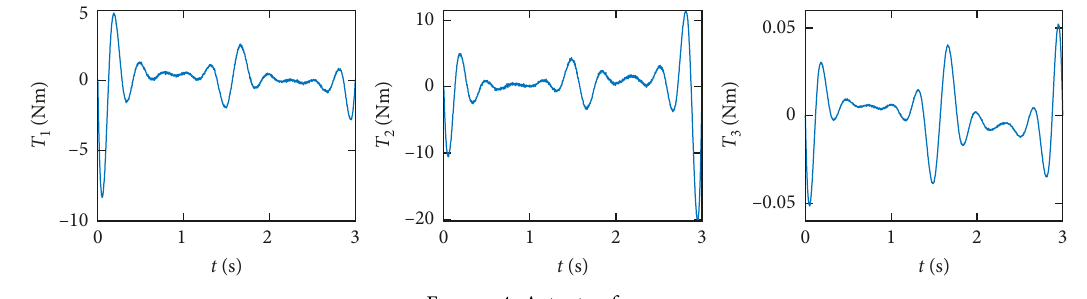
Figure 4: Actuator forces.